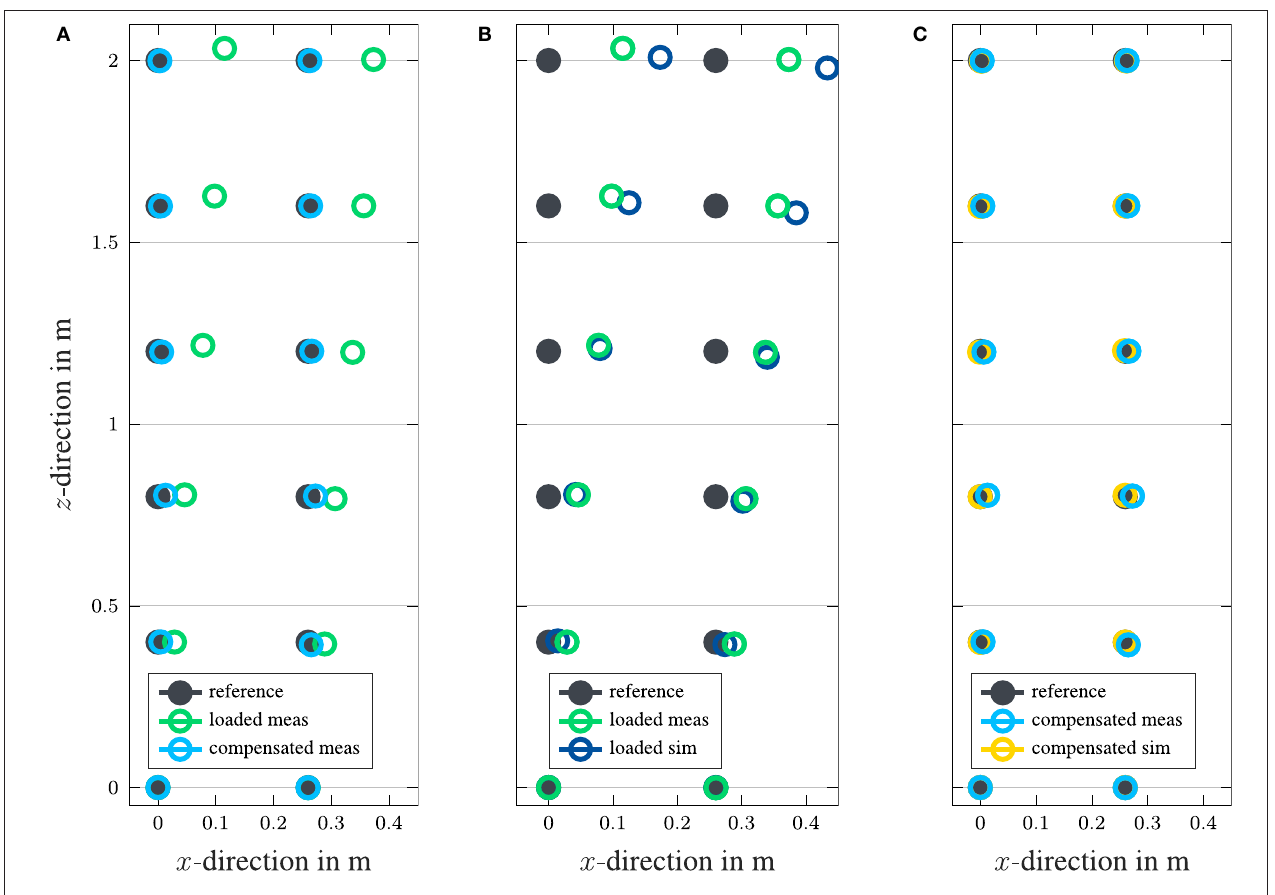
FIGURE 6 | Comparison of position data for measured (meas) and simulated (sim) models with the reference state (gray). (A) Measured positions for the loaded state (green) and compensation of the displacement (light blue). (B) Loaded structure measurement (green) and simulation (dark blue). (C) Compensated measurement (light blue) and simulation (yellow). The data is summarized in Table A1 (top) in the Appendix.